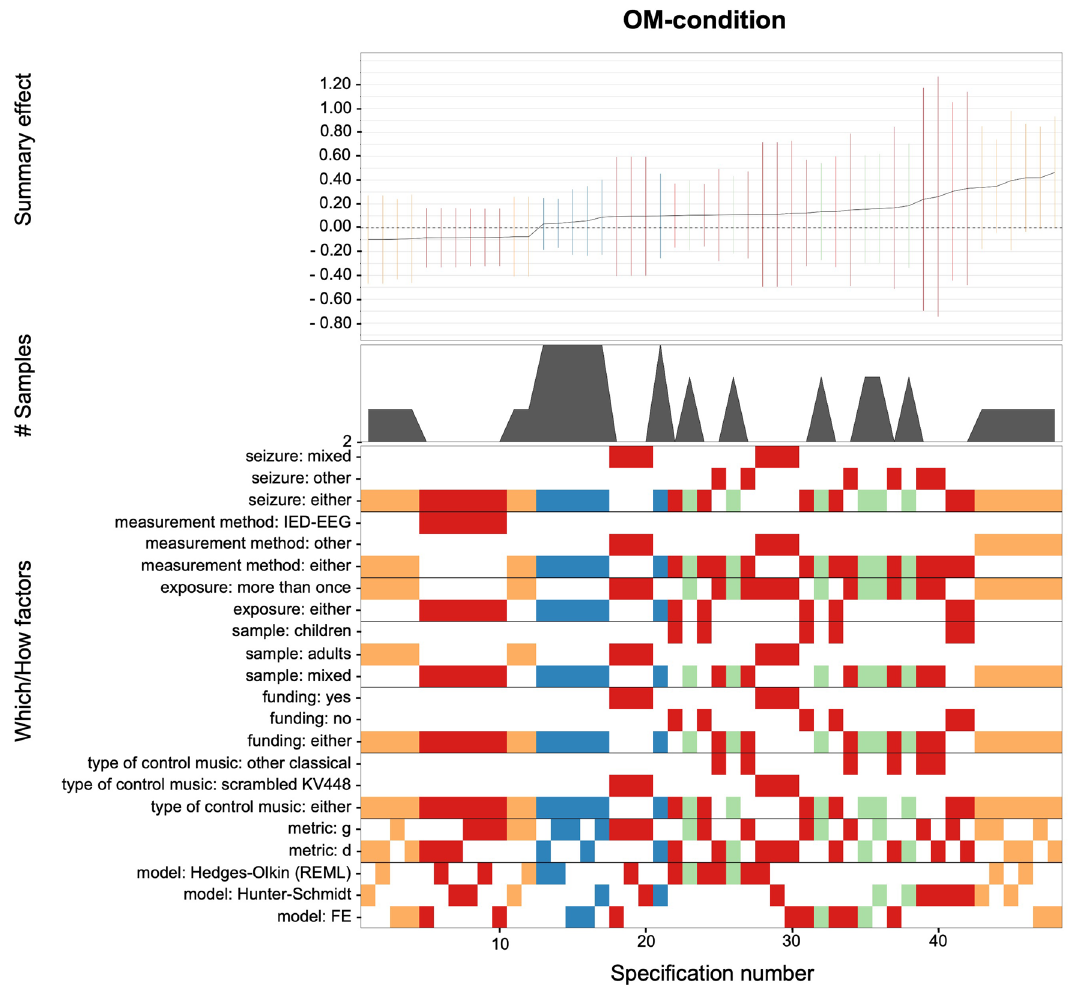
Figure 6. Descriptive meta-analytic specification plot of summary effects from all reasonable specifications for the OM-condition. The OM-condition includes studies with one-group pretest–posttest designs examining exposure to other music than KV448 versus silence 12,25,26,29 . The bottom panel indicates the “ which ” and “ how ” factors that were included (warmer vs. cooler spectral colors are indicative of lower vs. higher presision of estimates) for the estimated summary effects depicted in the top panel with respective 95% confidence intervals. The middle panel indicates the number of samples within the respective